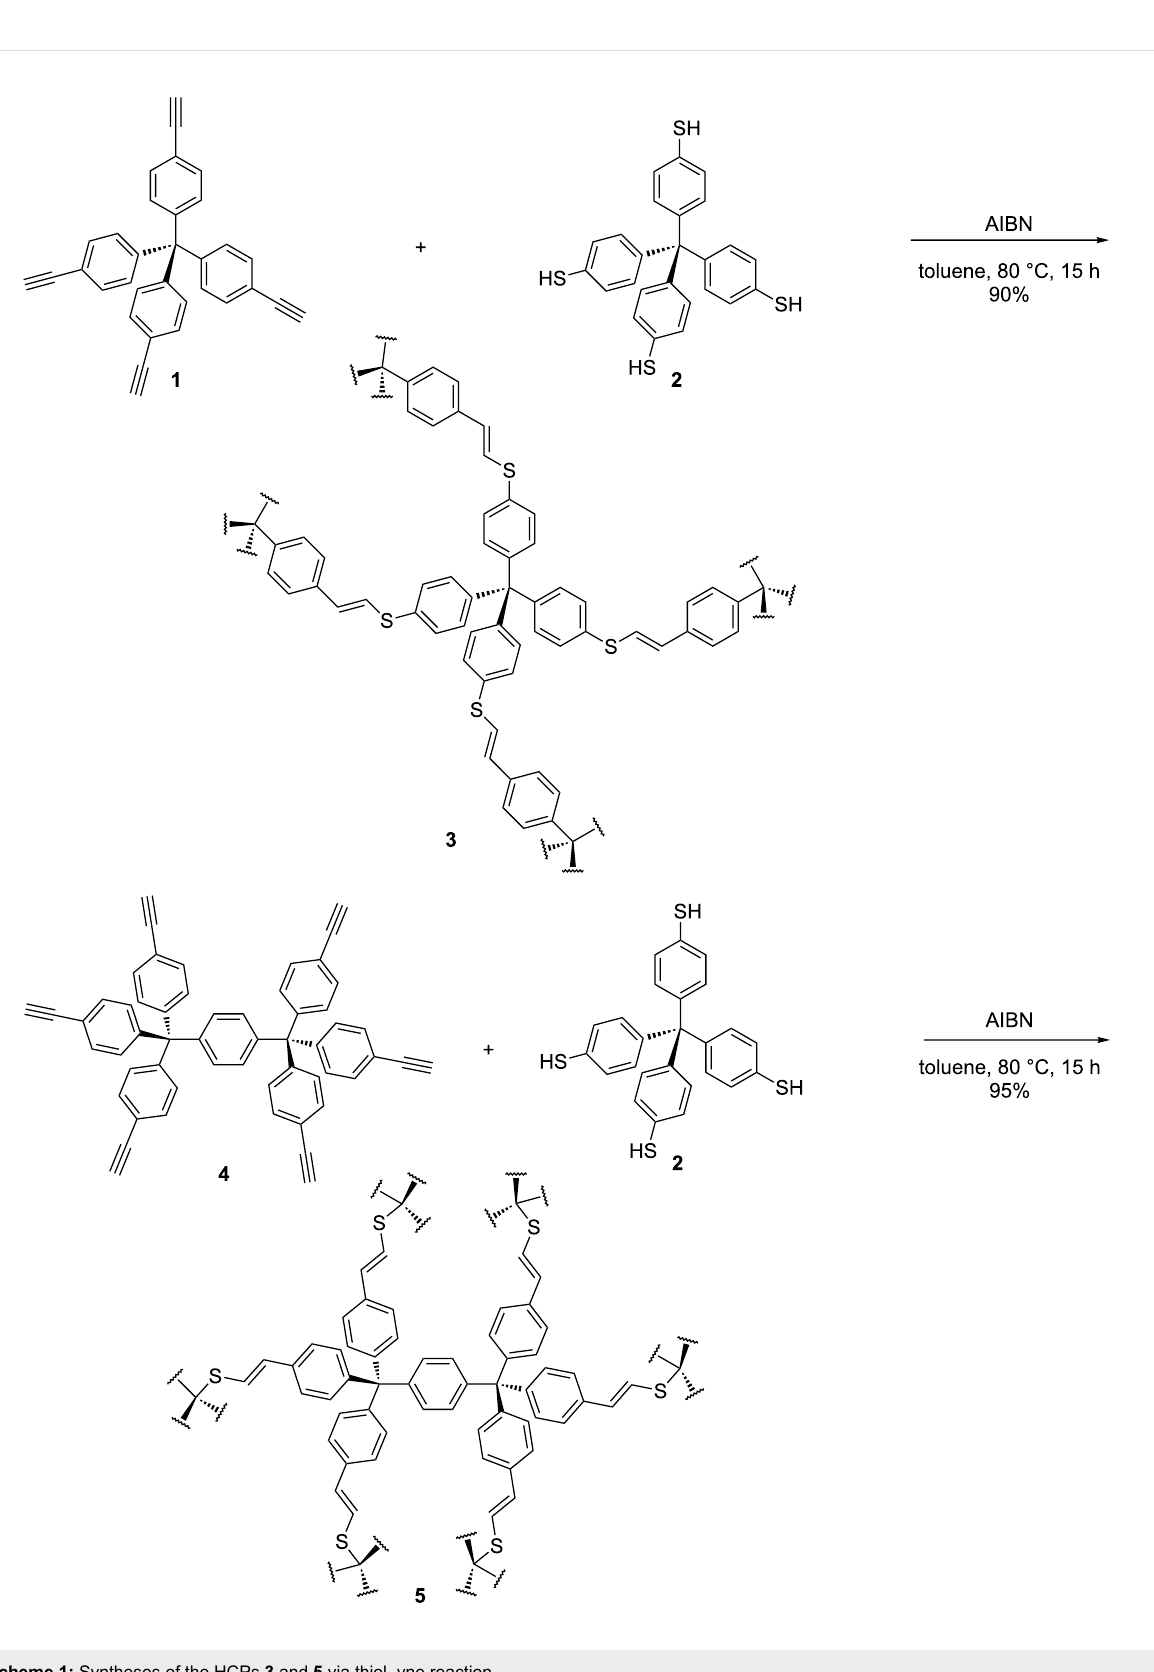
Scheme 1: Syntheses of the HCPs 3 and 5 via thiol–yne